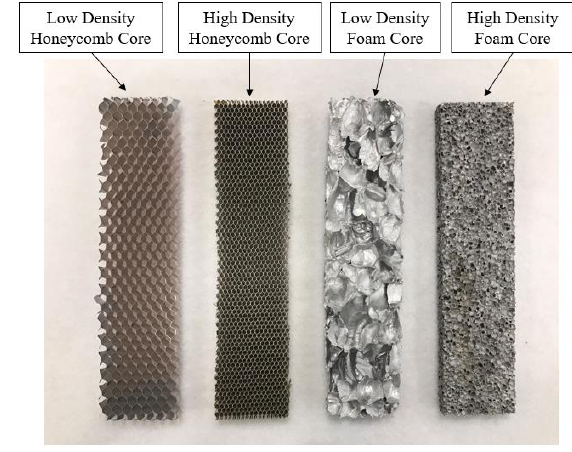
Figure 4. Different types of cores used in this study. Table 3. Core and Face sheet material properties.